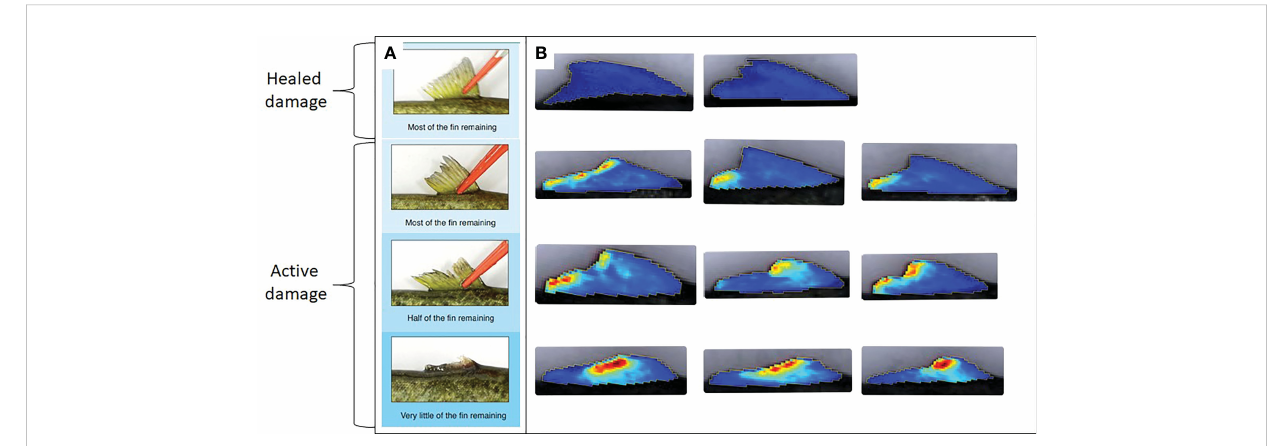
FIGURE 3 (A) Different categories of fi n erosion reproduced from FISHWELL with permission; Noble et al., 2018 distinguishing severity category as well as active vs healed/undamaged status. (B) corresponding fi n images from the present study with blood intensity visualized on a blue-red color scale from Breeze; Prediktera 2022).